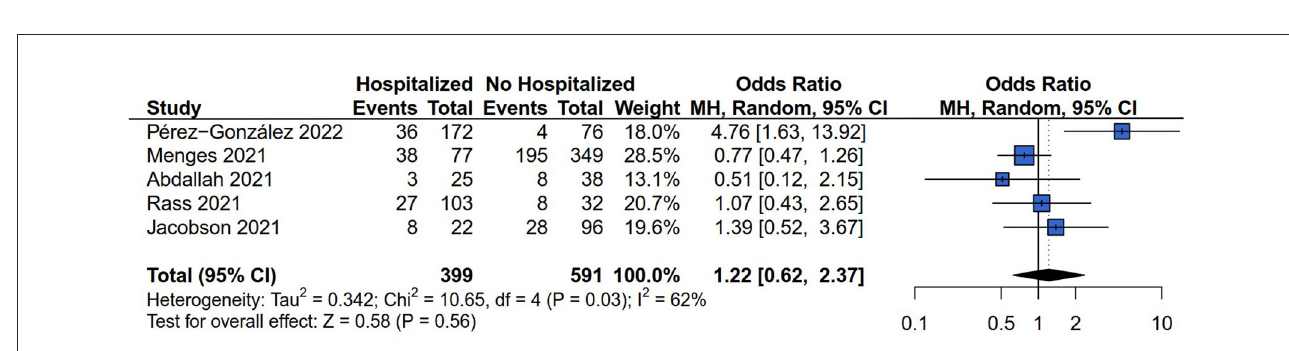
data synthesis. In these included studies, a total of 287 and 671 subjects were grouped into hospitalized and non-hospitalized